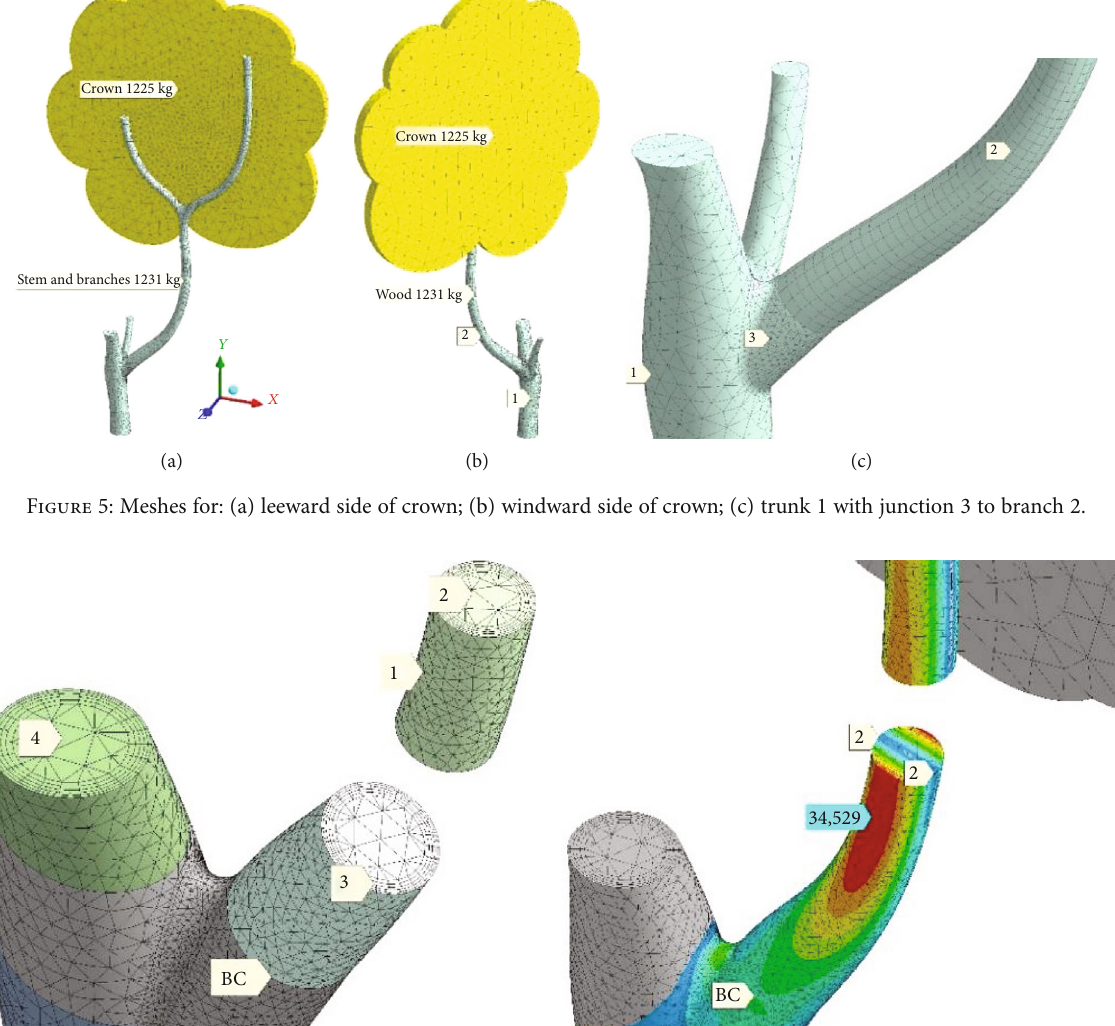
e ) (MPa) for LiBC condition set